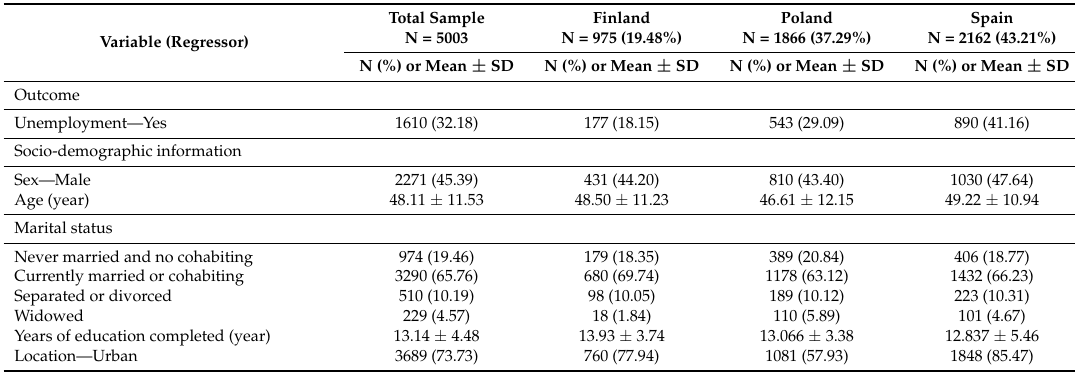
Table 1. Descriptive statistics (overall and by